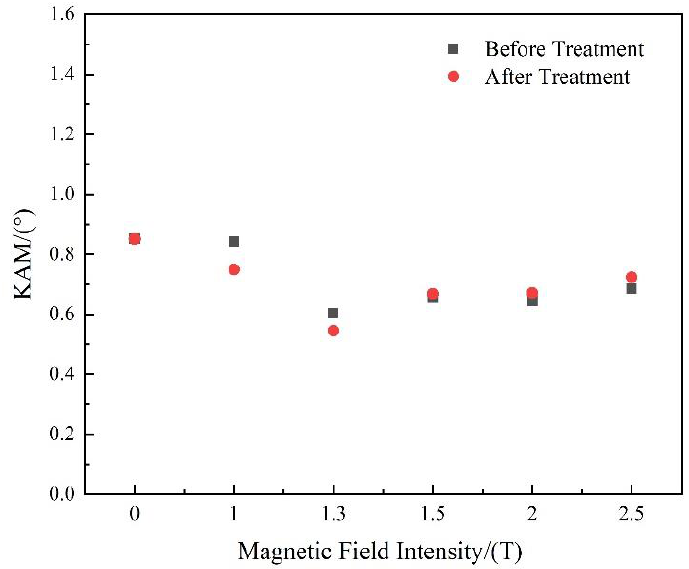
Figure 6. Average value of KAM before and after treatment at different magnetic fields.